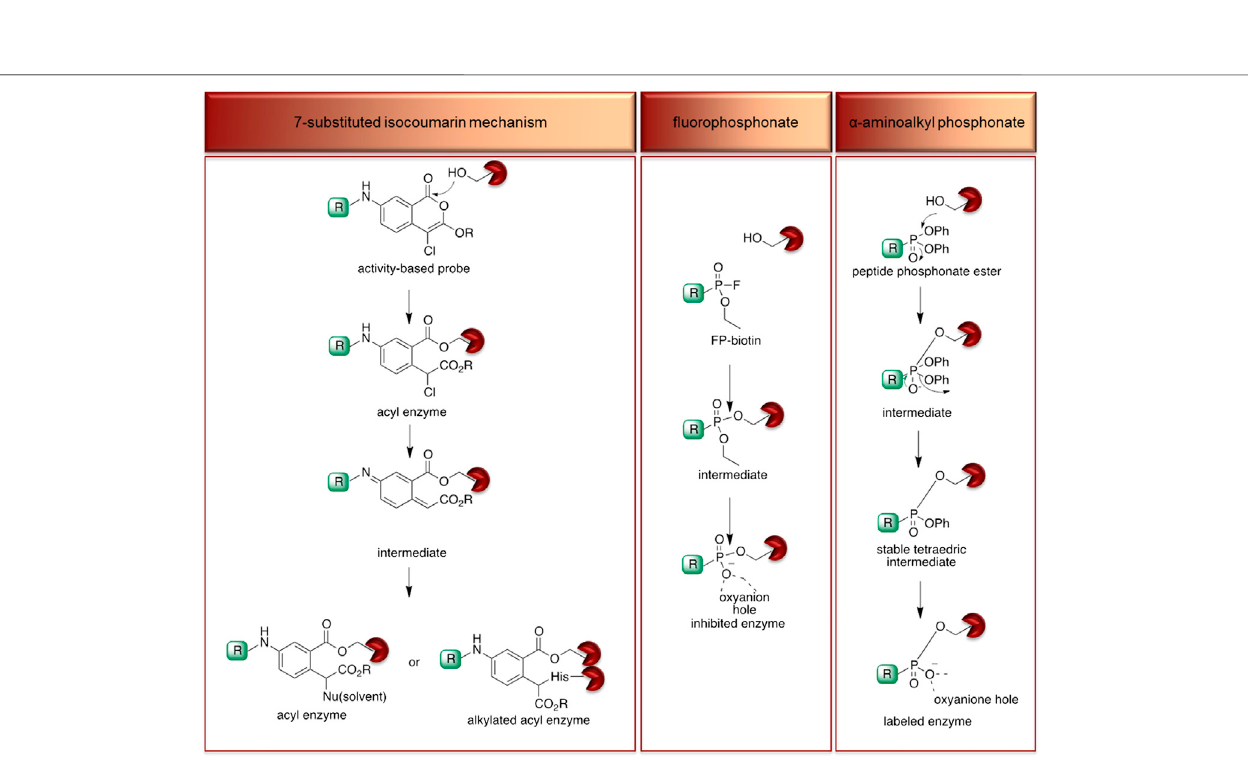
Frontiers in Chemistry |